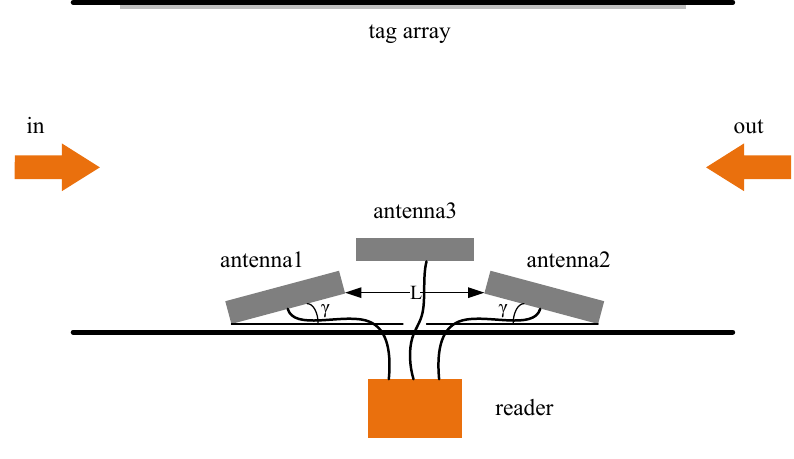
Figure 11. Top view of RF-Access